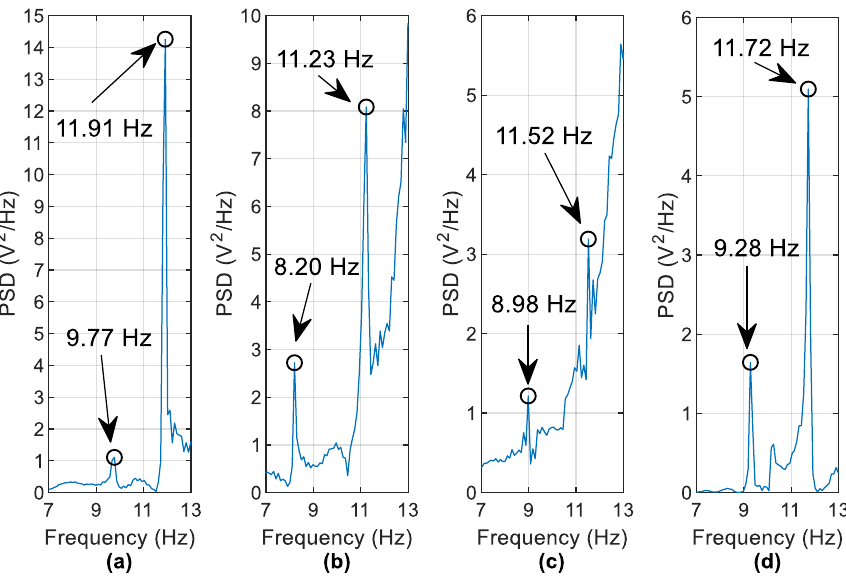
Figure 15. Frequency changes derived from acceleration data ( a ) Scour at Pier 2, ( b ) Scour at Pier 3.